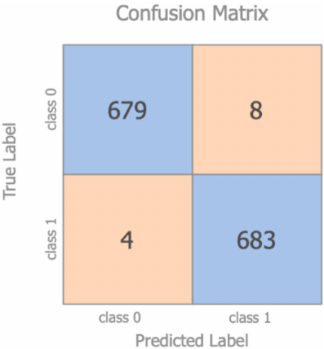
Figure 3. Confusion matrix–original vs. synthetic samples.